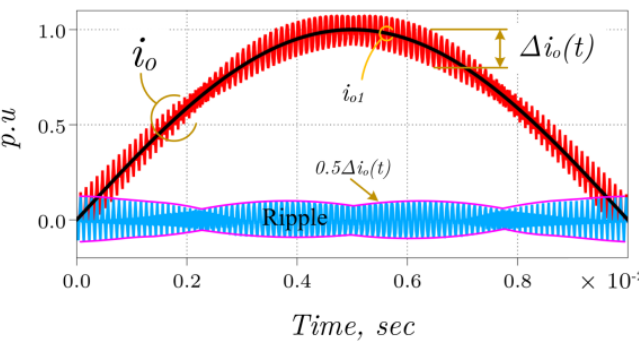
Figure 13. Evaluation of AC output current ripple using the time-domain analysis.